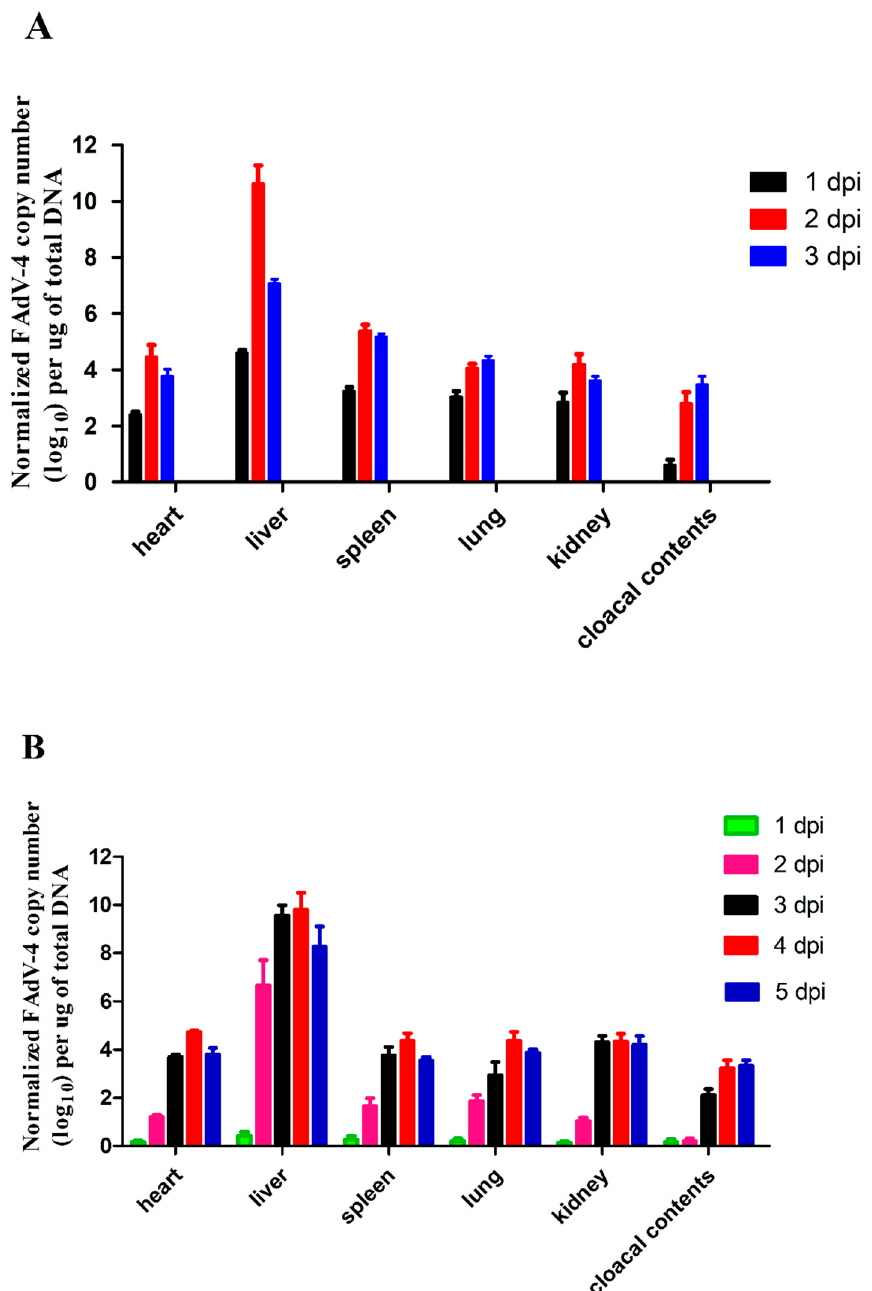
Figure 5. Viral titers in samples (heart, liver, spleen, lung, kidney, and cloacal contents) from FAdV-4 infected chickens. ( A ) FAdV-4-SDJN0105 DNA loads in the tissues and cloacal cotton swabs from intramuscularly infected chickens at 1, 2, and 3 dpi. ( B ) FAdV-4-SDJN0105 DNA loads in the tissues and cloacal cotton swabs from oculonasal infected chickens at 1, 2, 3, 4, and 5 dpi. Data are expressed as means ± standard deviations ( n = 3), and each sample was analyzed in triplicate. dpi, days post- infection.